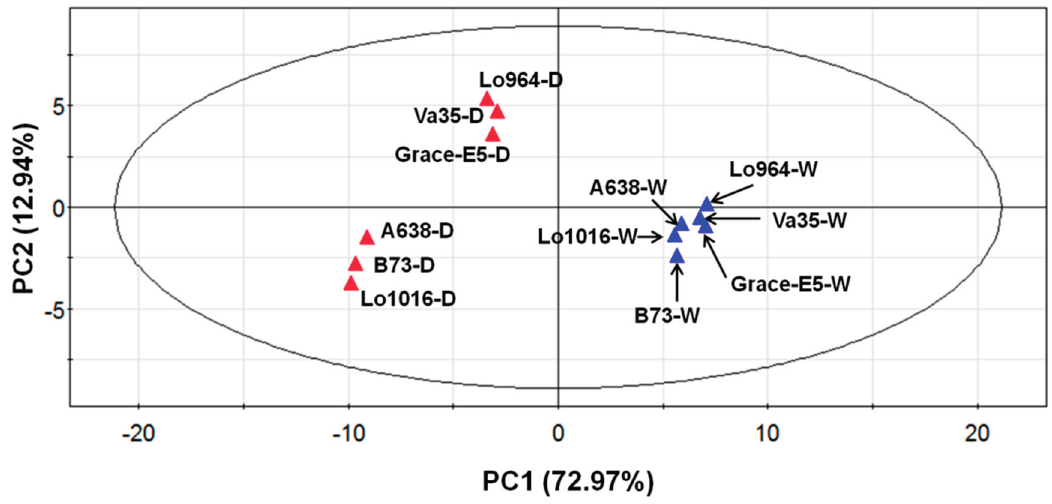
Figure 7. Principal component analysis (PCA) of all physiological and biochemical data in six different lines under well-watered and drought treated conditions. The blue points represent the well-watered (W) plants, while the red points represent the drought-stressed (D)